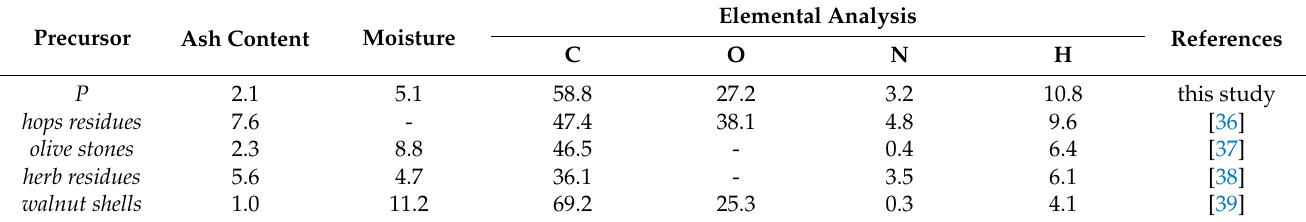
Table 2. Elemental analysis of agricultural waste materials that can be used as precursors of activated carbons [%